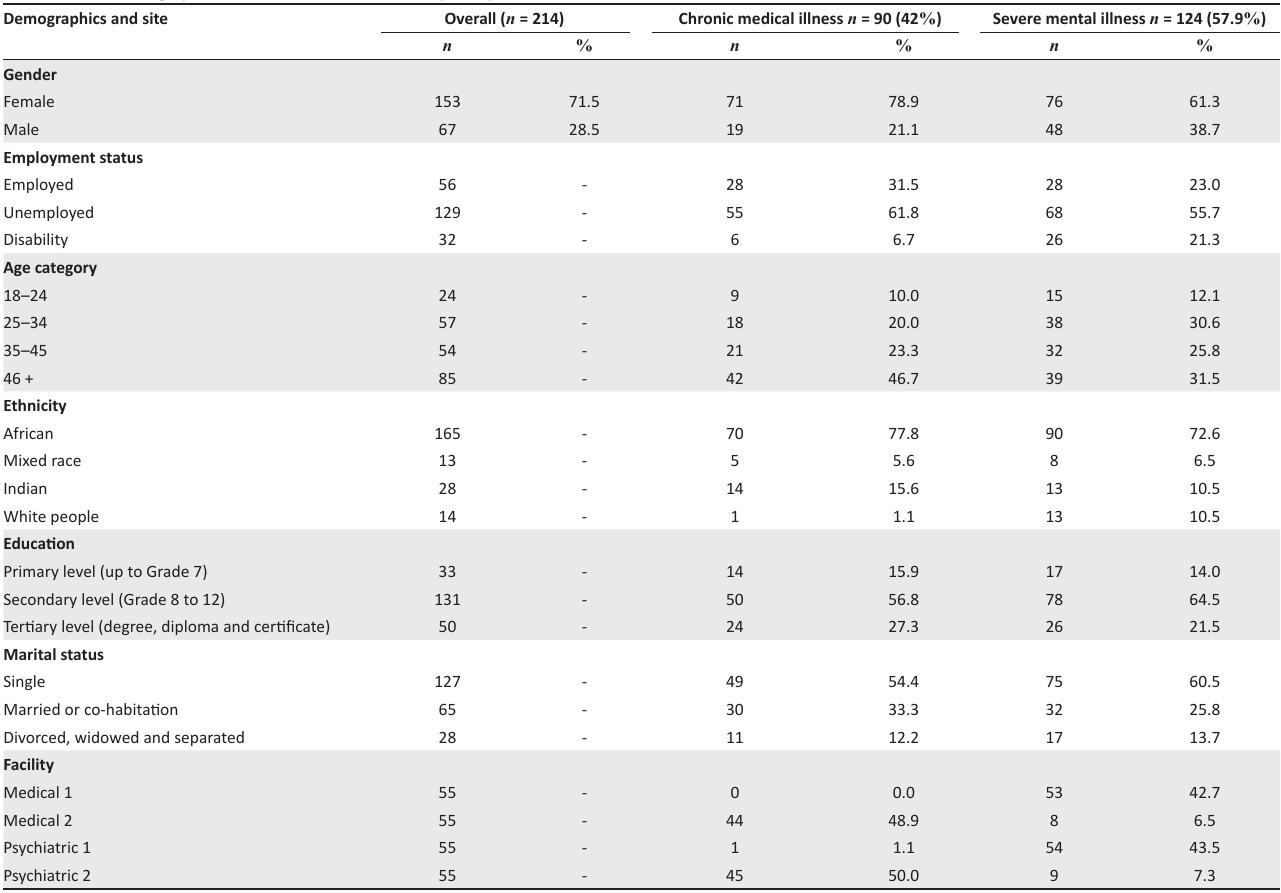
TABLE 1: Sociodemographic and clinical characteristics of participants. Demographics and